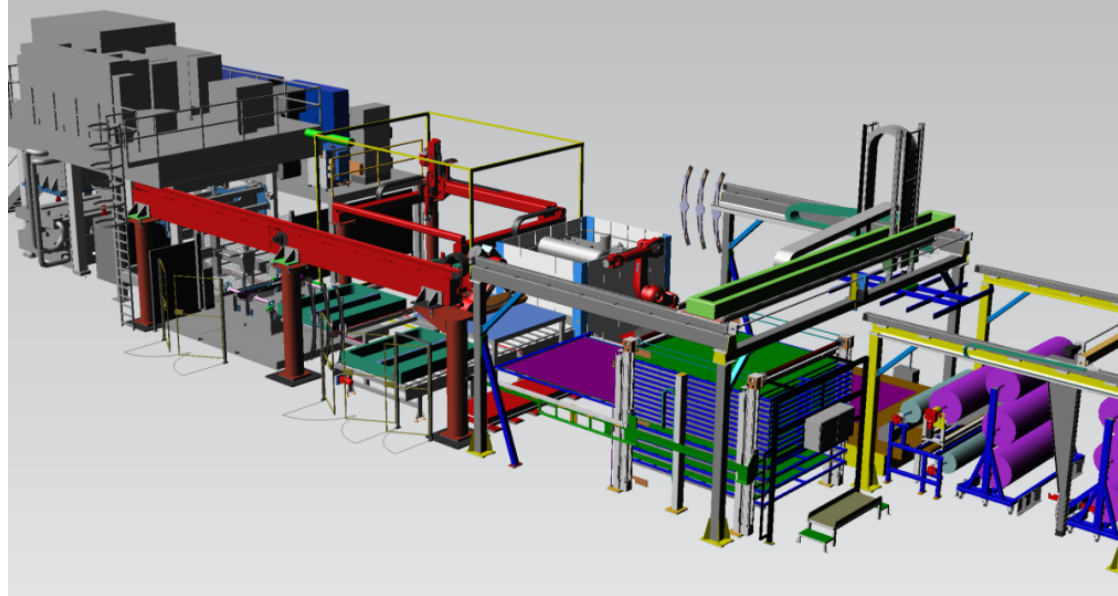
Figure 1: CAD-overview of EVo - research